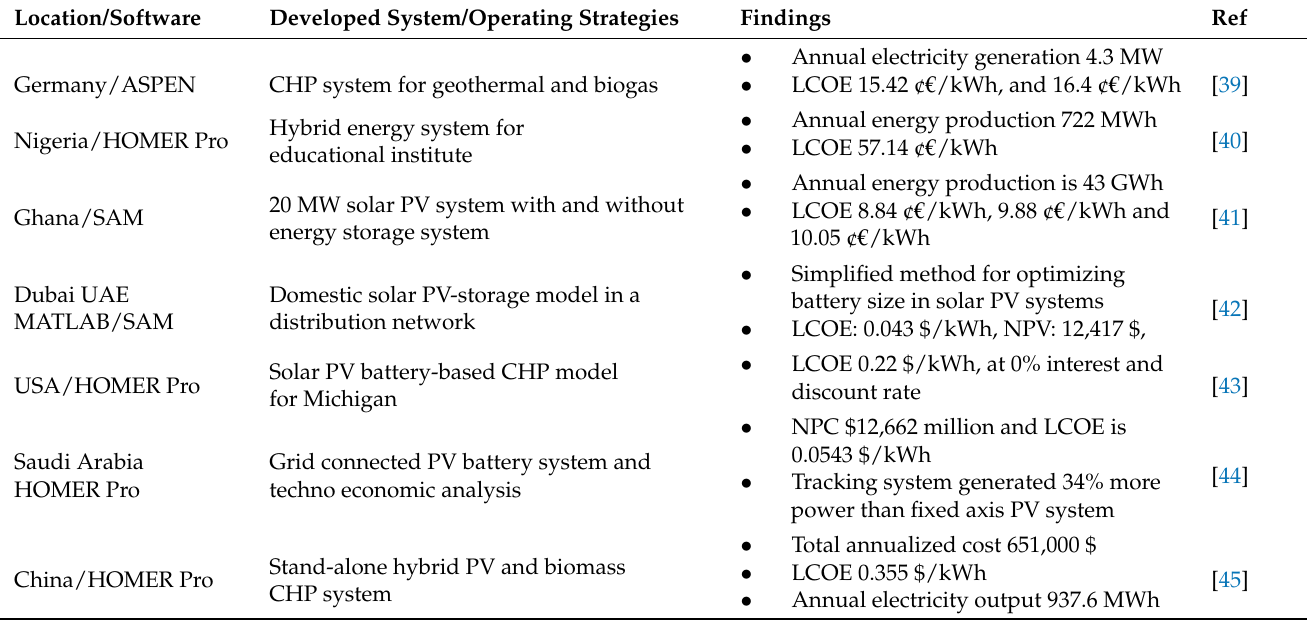
Table 1. Literature review of latest published articles of renewable energy